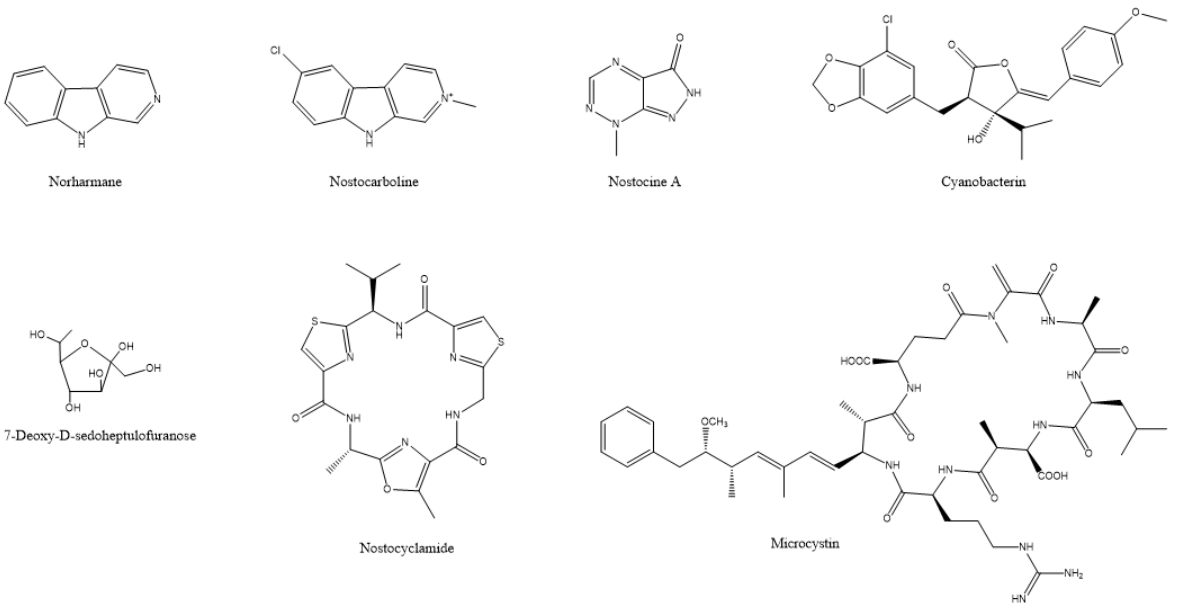
Figure 5. The chemical structures of active compounds that were isolated from Synechocystis aquatilis , Scytonema hofmanni , Nostoc sp., Microcystis aeruginosa , and Synechococcus elongatus .